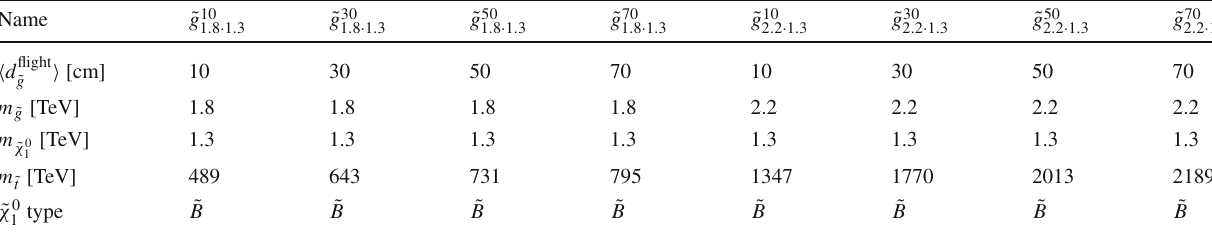
Table 7 Definition of the eight benchmarks for the long-lived gluino analysis